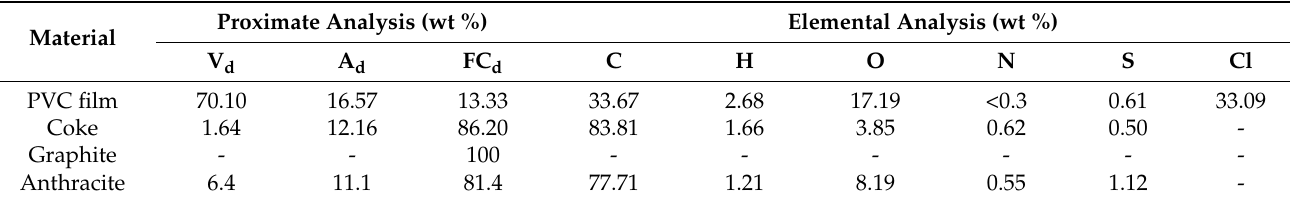
Table 1. Proximate and elemental analysis of raw materials.